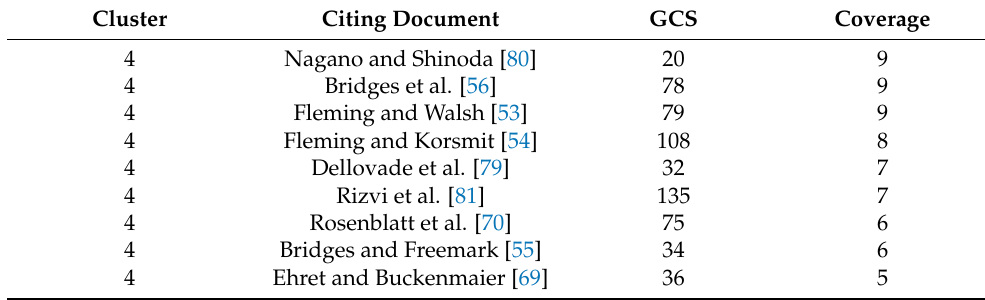
Table 4. All the 9 citing documents in cluster #4 identified using the